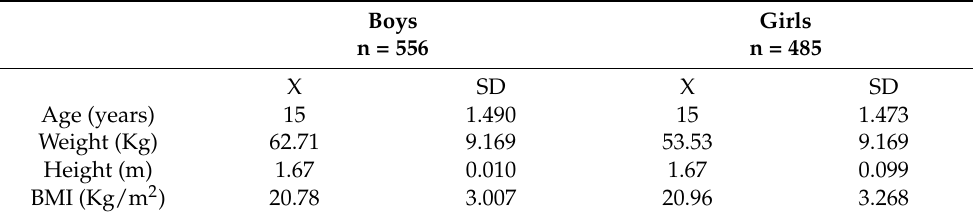
Table 2. Means and standard deviations of age, weight, height and BMI by